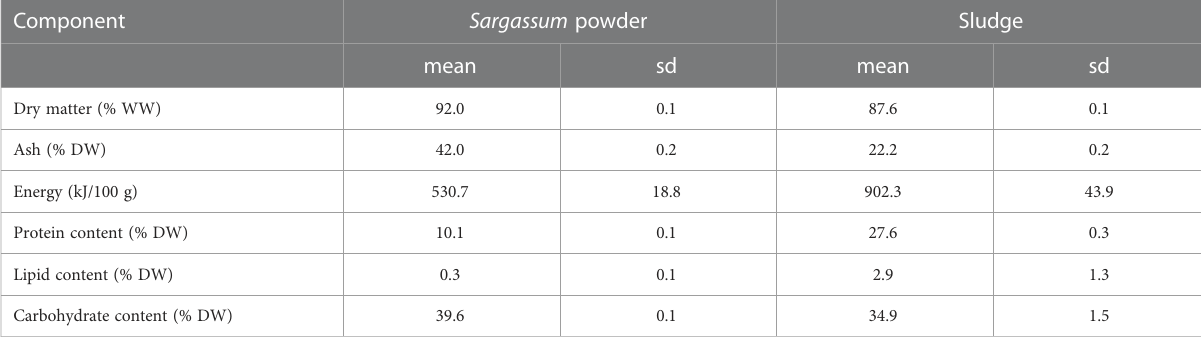
TABLE 1 Macronutrient composition, dry matter, ash and energy content of the experimental feed ingredients (n=3, sd=standard deviation). Component